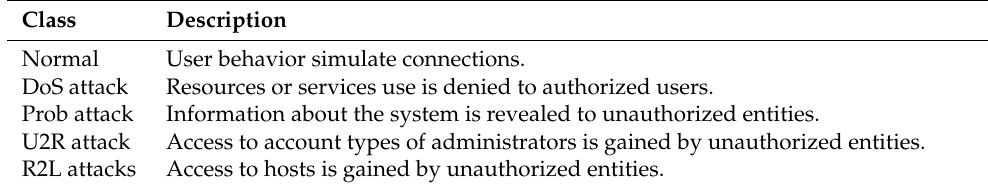
Table 3. Detail of classes in KDD-CUP 99 and NSL-KDD datasets.